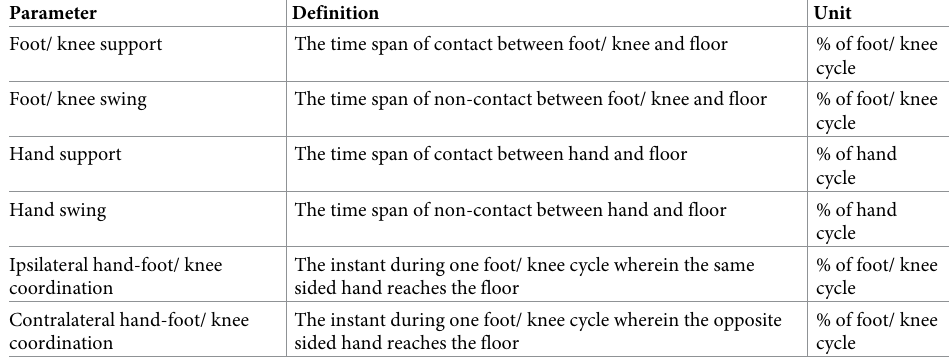
The instant during one foot/ knee cycle wherein the same sided hand reaches the floor The instant during one foot/ knee cycle wherein the opposite sided hand reaches the floor